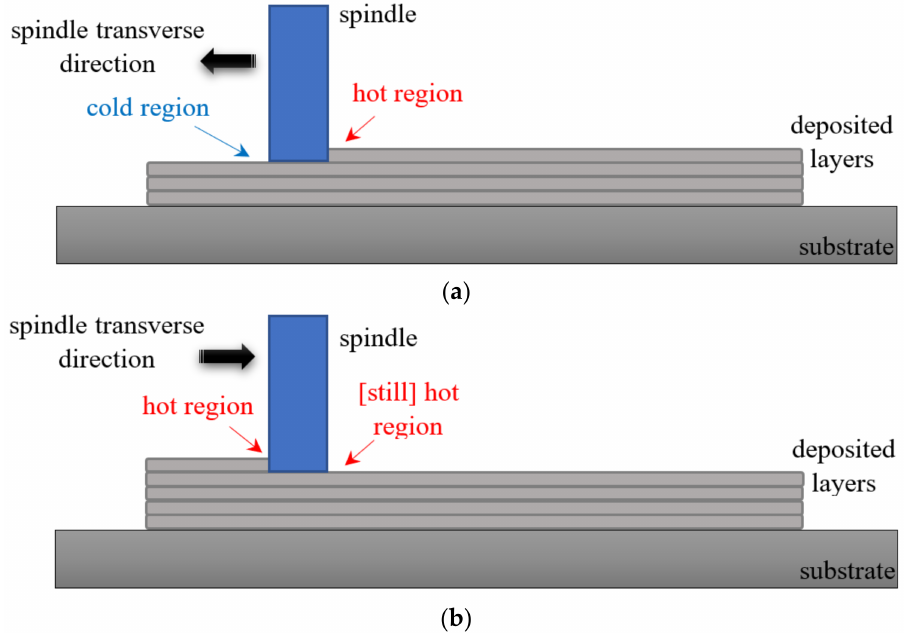
Figure 7. Layer deposition schematic figure: ( a ) hot-on-cold deposition, ( b ) hot-on-hot